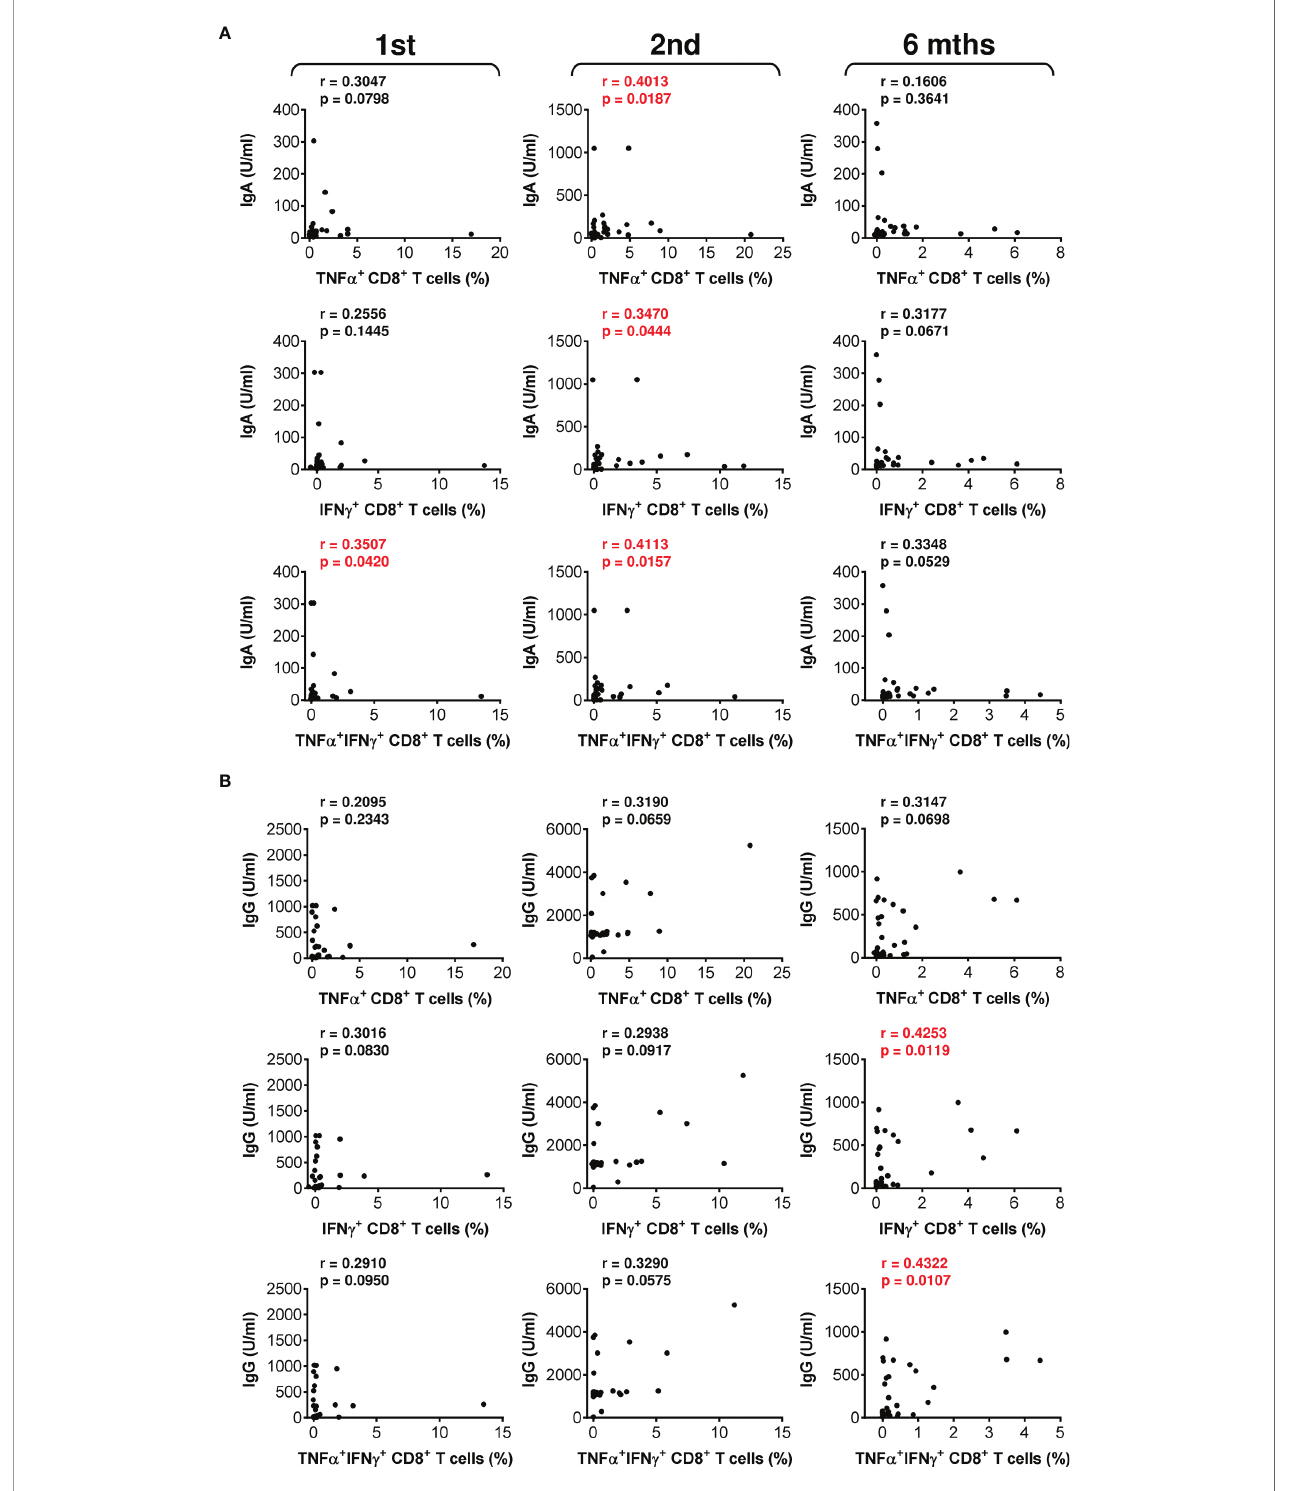
FIGURE 4 | The associations between SARS-CoV-2 spike glycoprotein peptide-reactive CD8 + T cells and the serum levels of anti-RBD antibodies during and after vaccination. (A, B) The correlations between the frequencies of peptide-reactive TNF a -, IFN g -, or TNF a /IFN g -producing CD8 + T cells and serum levels (U/ml) of anti- RBD IgA (A) or IgG (B) antibodies before (1st) and 4 weeks (2nd) and 6 months (6 mths) after the second vaccine dose was administered. Spearman ’ s rank-order correlation coef fi cient (r) and the signi fi cance ( p value; n = 34) are